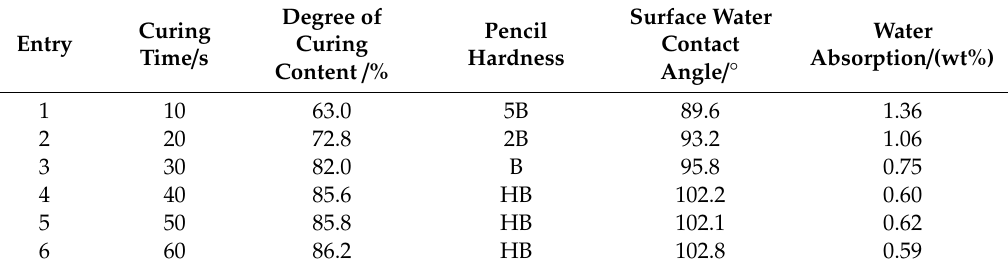
Table 3. The influence of curing time on the silicone coatings